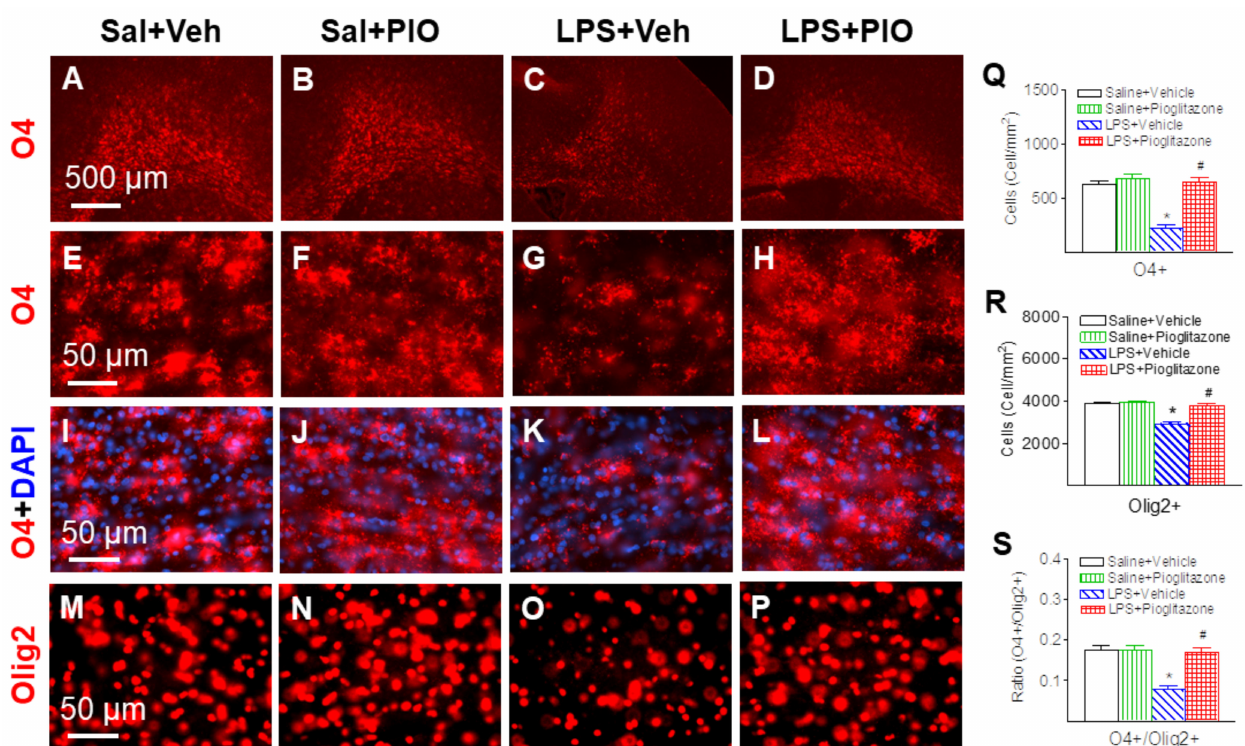
Figure 4. Pioglitazone attenuated neonatal LPS-induced reduction of late oligodendrocyte progenitor cells (O4+/O1 − ) and total oligodendrocytes (Olig2+) in the P6 rat brain. Abundant O4+ (Saline+Vehicle group: ( A , E , I ); Saline+Pioglitazone group: ( B , F , J )), which positively stained the cell membrane and processes, and Olig2+ (Saline+Vehicle group: ( M ); Saline+Pioglitazone group: ( N )) were found in the cingulum white matter of the brain sections at the bregma level in P6 Saline+Vehicle and Saline+Pioglitazone groups. DAPI (blue) was used simultaneously to identify nuclei in the final visualization ( I – L ). LPS injection reduced the number of normal O4+ cells ( C , G , K ) and Olig2+ cells ( O ). Pioglitazone attenuated LPS-induced loss of O4+ cells ( D , H , L ) and Olig2+ cells ( P ). Late oligodendrocyte progenitor cells and total oligodendrocytes were quantified by counting the number of O4+ cells ( Q ) and Olig+ cells in the cingulum white matter of the brain ( R ), respectively. The ratio of late oligodendrocyte progenitor cells (O4+/O1 − ) to total oligodendrocytes (Olig2+) in each group were shown in ( S ). The results are expressed as the mean ± SEM of eight animals in each group, and analyzed by two-way ANOVA, followed by the Student–Newman–Keuls test. * p < 0.05 represents a significant difference for the LPS + Vehicle group as compared with the Saline + Vehicle group. # p < 0.05 represents a significant difference for the LPS + Pioglitazone group as compared with the LPS + Vehicle